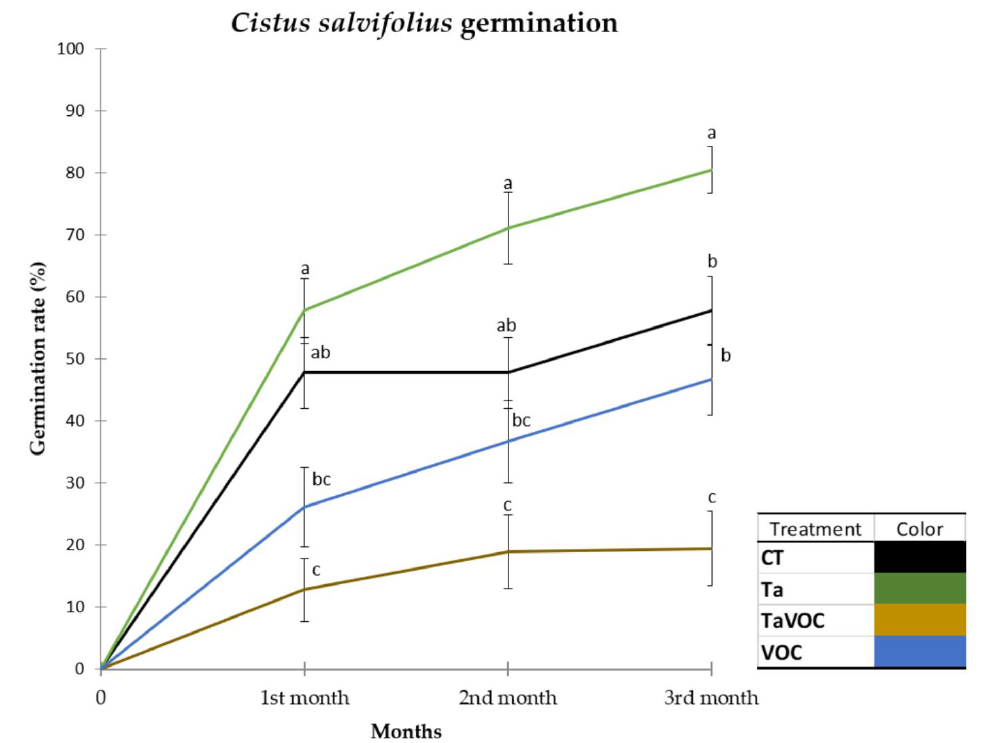
Figure 5. Cistus salviifolius seeds germination over three months, showing the effect of Terfezia arenaria inoculum and 1-octen-3-ol on Cistus salviifolius (N = 18 per treatment). Treatments: CT—control; VOC — 1-octen-3-ol 1 µM; Ta — Terfezia arenaria inoculum; TaVOC — T. arenaria inoculum and 1-octen-3-ol 1 µM. Data were compared using a Kruskall – Wallis test. Post hoc comparisons were made using a Dunn ’ s test. Data are mean ± standard error. Different letters show significant differences ( p < 0.05) between treatments.